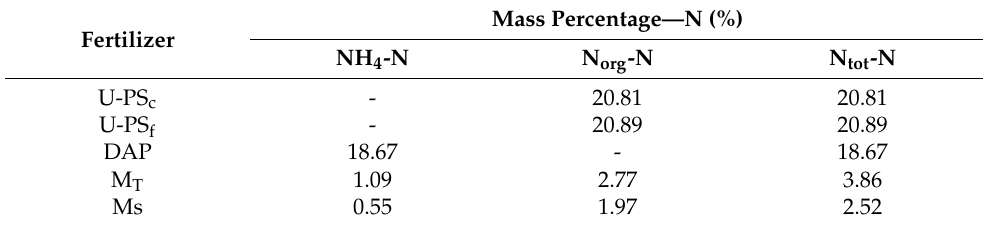
Table 1. Fertilizer characteristics—nitrogen content in dry mass (%). Fertilizer